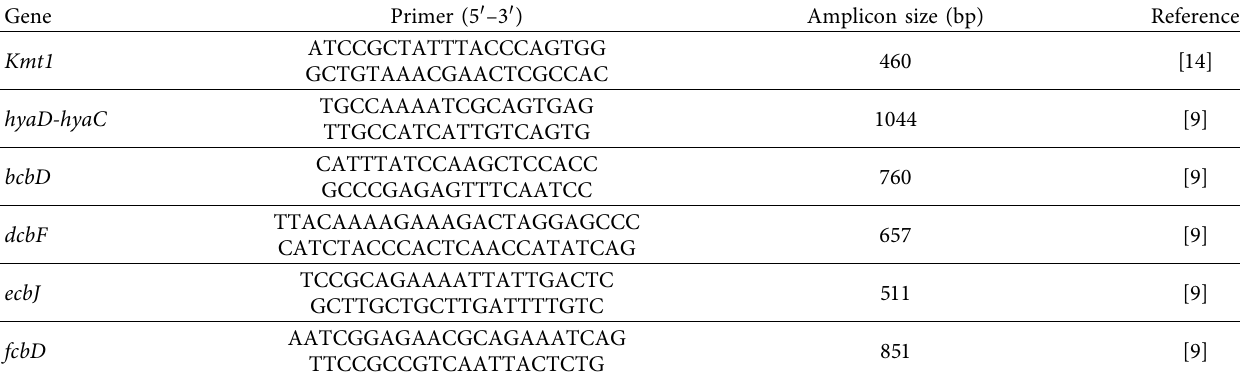
Table 1: Sequences of oligonucleotide primers used for identification and capsular typing of P. multocida. Gene Primer (5 ′ –3 ′